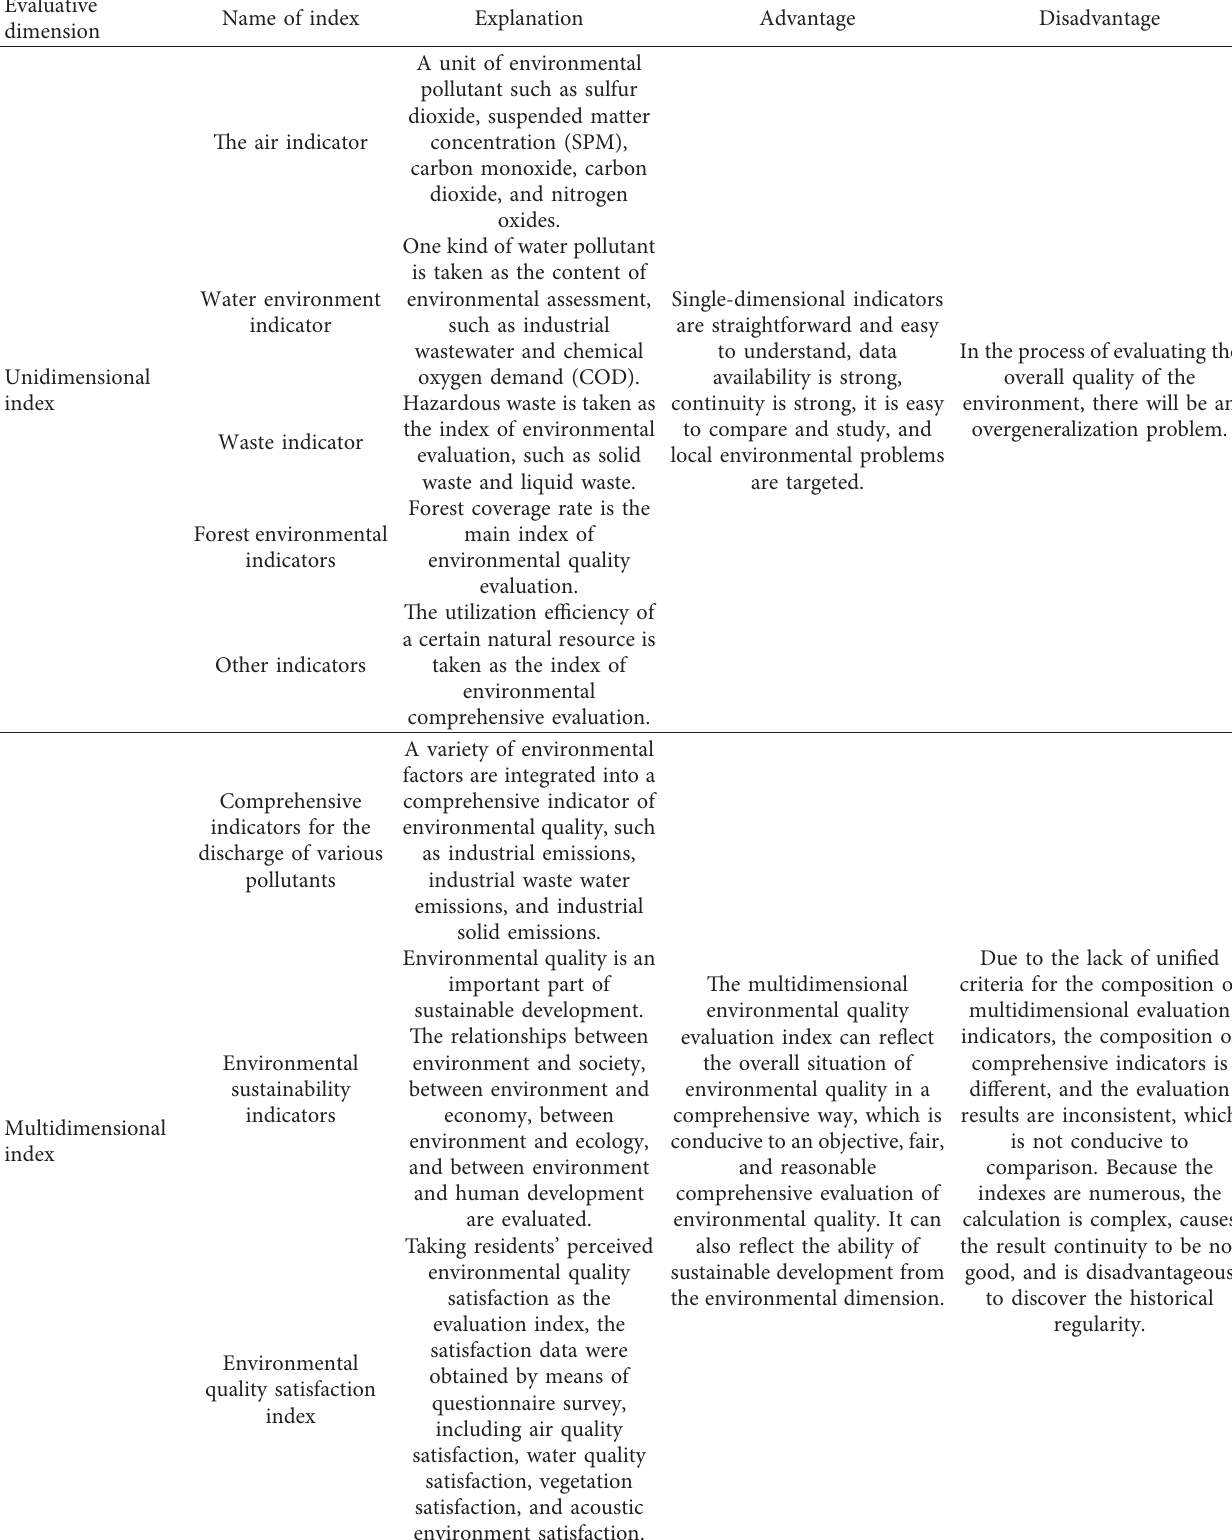
Table 1: Comparison of environmental quality assessment